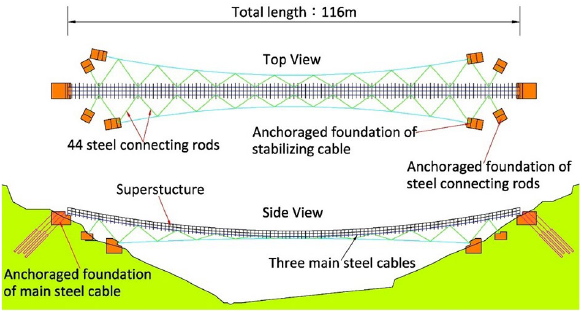
Figure 1. Suspension bridge